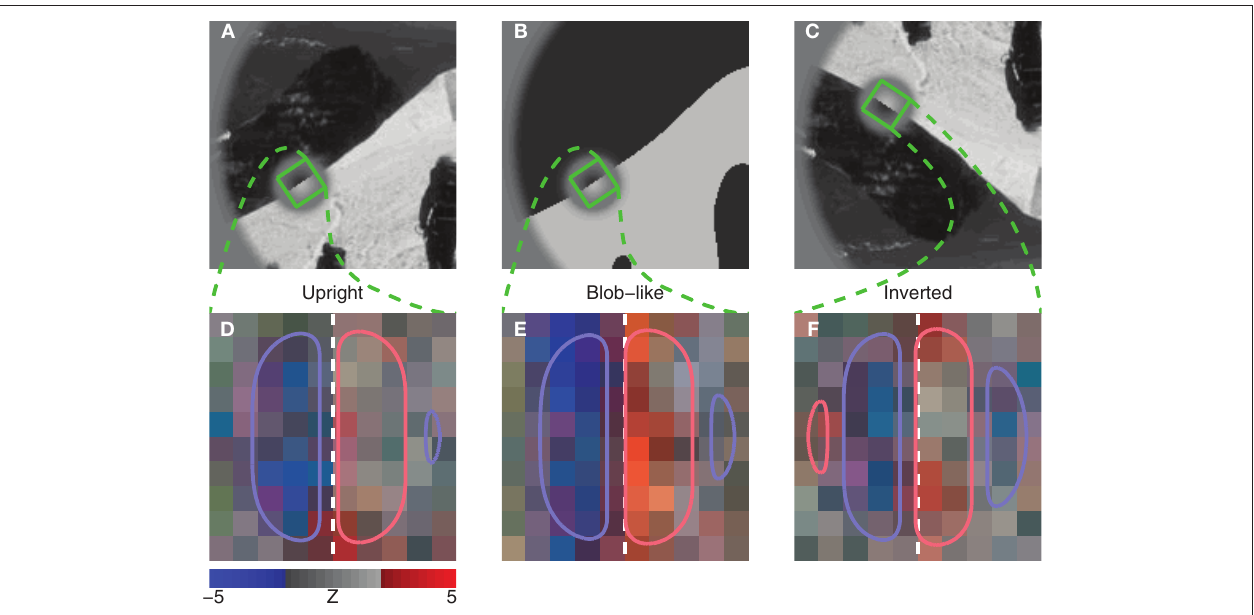
Figure 4 | Perceptual filters (D–F) for upright natural (A), blob-like (B) and inverted images (C). Plotted to the same conventions of Figure 2J . Dashed vertical lines indicate target